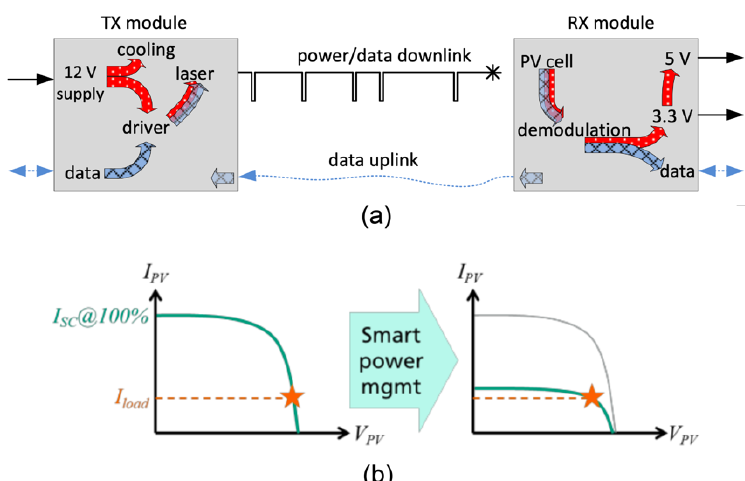
Figure 9. ( a ) Basic concept of integrated optical data transmission system [48] and ( b ) smart power management system [49].